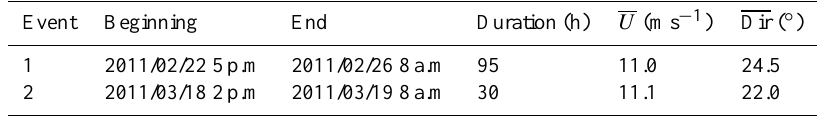
Table 1. Main characteristics of the blowing snow events used for the evaluation of Meso-NH/Crocus. U and Dir represent, respectively, the average 5 m wind speed and direction at Lac Blanc AWS (Fig. 3).